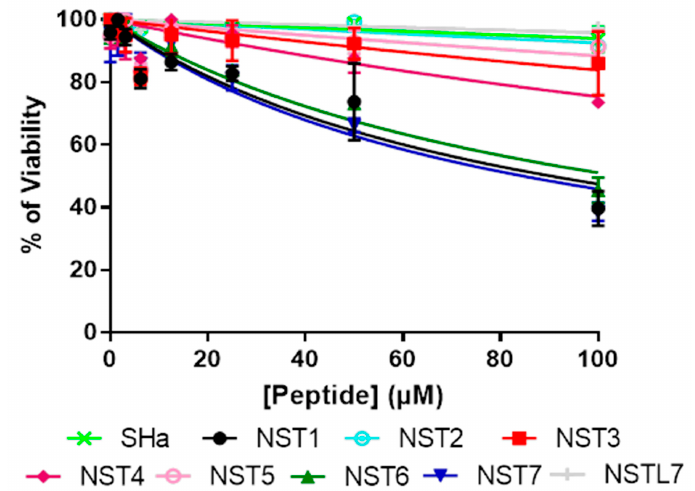
Figure 5. In vitro evaluation of the cytotoxicity of temporin-SHa and its analogs using human gastric cells. Dose-dependent effect of 48 h incubation with increasing doses of temporin-SHa and its analogs on the viability of human gastric cells (N87 cells) was measured using the metabolic activity resazurin assays. Results are expressed as percentage of cell viability with respect to concentration (in μ M) of peptides. Curves were fitted using the GraphPad ® Prism 7 software. Results were expressed as means +/- SD ( n = 3).